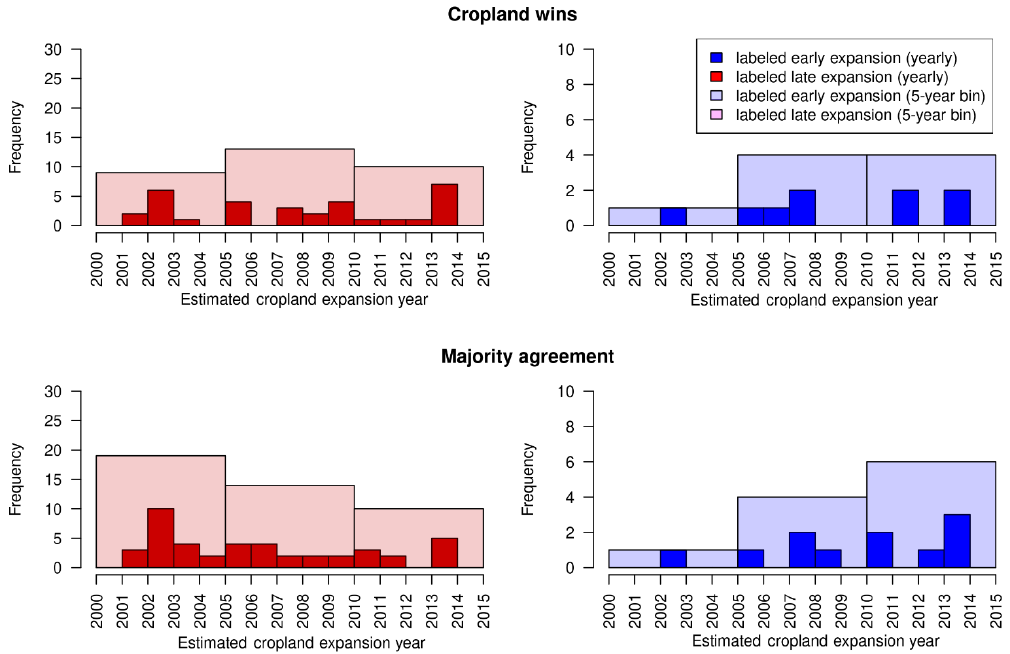
Figure 10. Reference labels (based on the cropland wins (upper) and majority agreement (lower) strategy to determine label class) of early cropland expansion (2000 = non-crop, 2010 and 2015 = crop) and late cropland expansion (2000 and 2010 = non-crop, 2015 = crop), and their corresponding estimated cropland expansion year ( x -axis) from the shapelet method. A slope threshold of 0.005 was used to detect cropland expansion, to maximize the amount of cropland gain detected. The histograms do not include cropland expansion events that the method failed to detect. Darker bars indicate the number of gain events in individual years, while lighter bars summarize the number of events in five-year intervals.